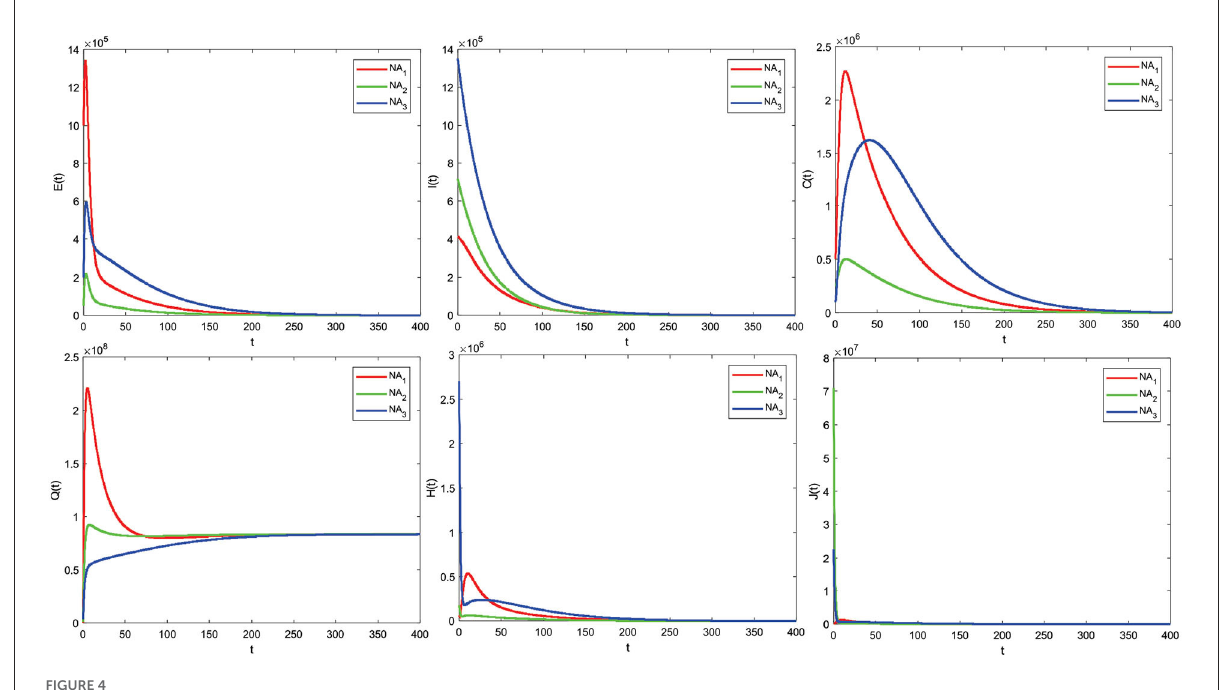
FIGURE4 COVID-19 model solution graph for R 0 < 1.